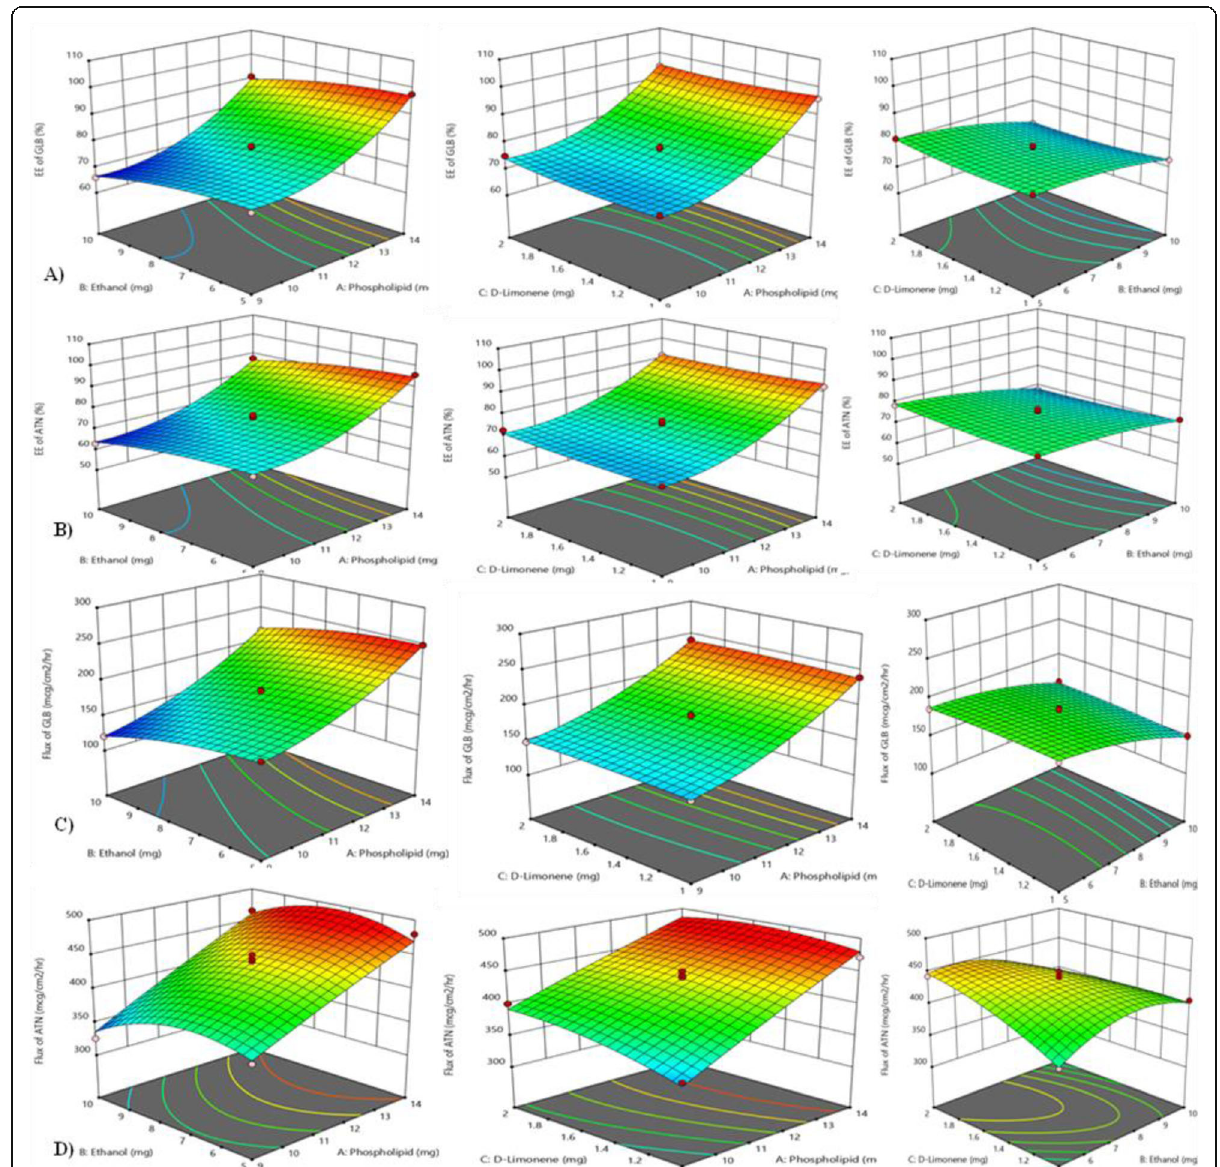
Fig. 2 3D-Response surface plots presenting the effect of three selected factors on a % EE of GLB, b % EE of ATN, and c flux of GLB and d flux of